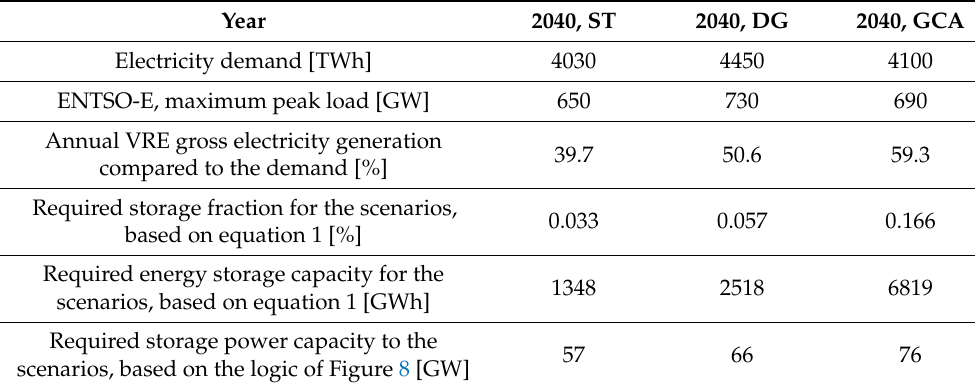
Table 9. Results related to the European storage power capacity and energy storage capacity requirements in